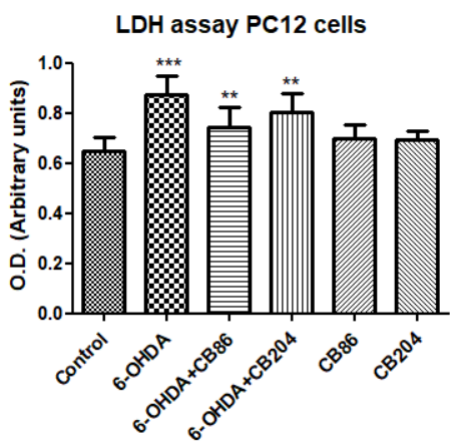
Figure 3. Cell cytotoxicity assay with LDH kit: cell cytotoxicity was induced by exposure of PC12 cells to 80 µM 6-OHDA for 24 h. Simultaneously, the PC12 cells were treated with CB86 or CB204 (25 µM each) for 24 h. Results are expressed by mean ± SD ( n = 16 in control and n = 8 replicates in all other groups). ANOVA followed by Bonferroni’s post -hoc test was performed, *** compared to control, ** compared to 6-OHDA and 6-OHDA+CB204; p < 0.001 for all.